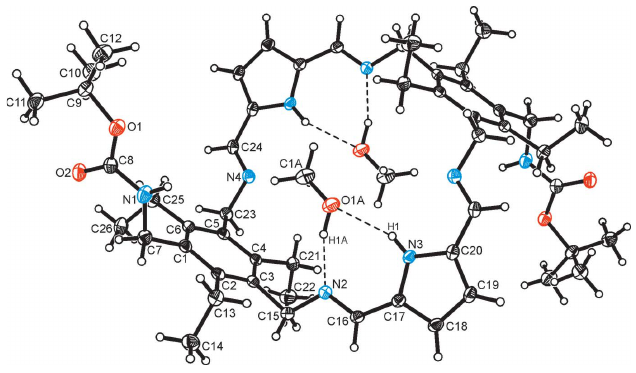
Figure 1 Perspective view of the 1:2 host–guest complex with methanol including the atom labeling. Anisotropic displacement ellipsoids are drawn at the 50% probability level.